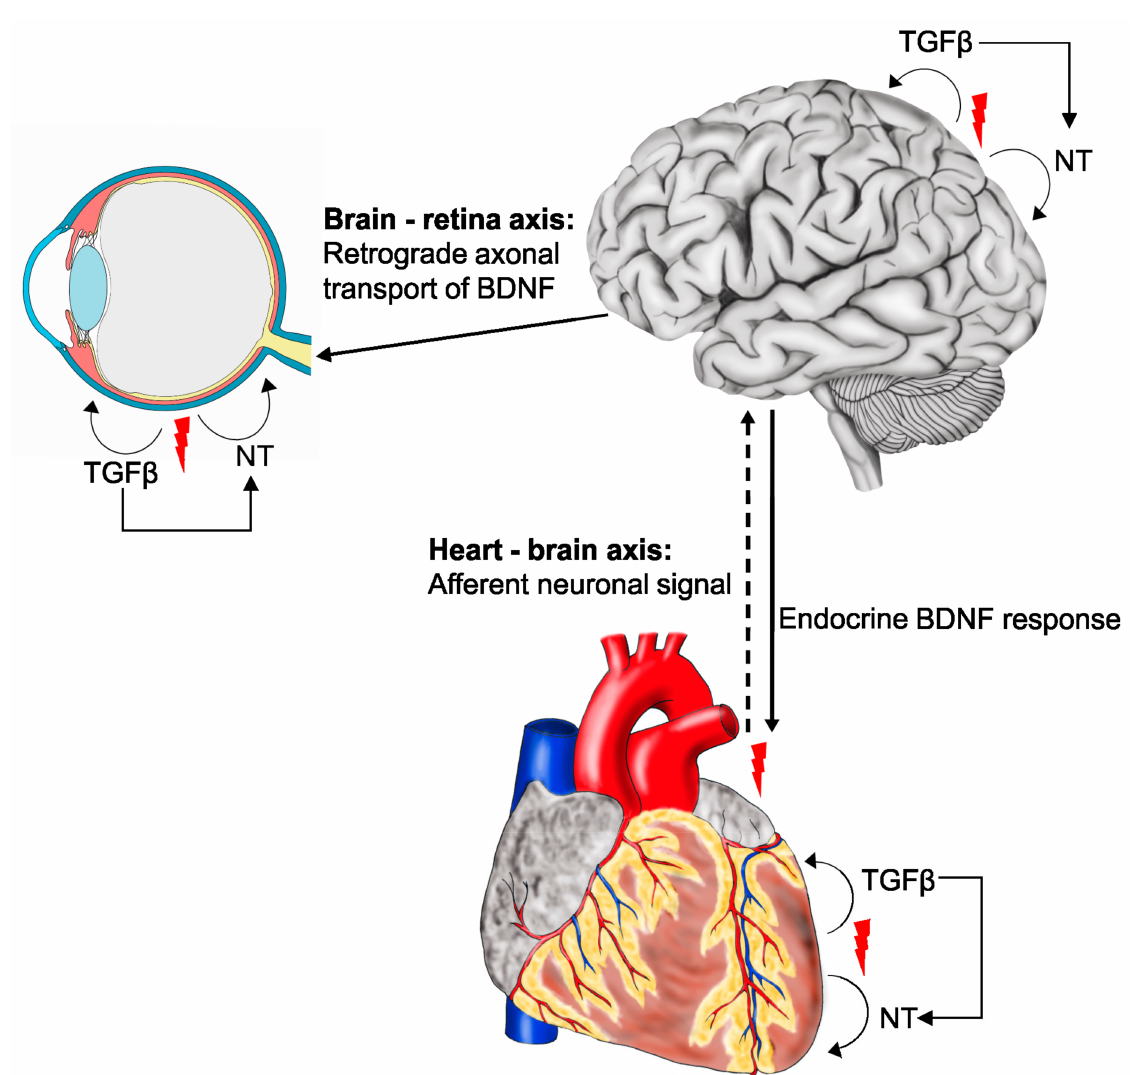
Figure 6. The heart-brain and brain-retina axis. Neurotrophins (NT) and TGF β are upregulated following ischemic insults (red lightning symbol) to the heart, retina, and brain. Following myocardial infarction, the heart-brain axis is activated by transmitting mechano- and chemo-sensitive information through cardiac afferent fibers (dotted arrow) to the brain, which responds by releasing BDNF to the bloodstream. Thus, BDNF promotes recovery from myocardial infarction by endocrine and paracrine actions. TGF β directly affects repair processes following ischemic insults. Moreover, it has the ability to increase the expression of NT. Additionally, retrograde transport of neurotrophins is essential for survival of retinal ganglion cells. This close relationship could be defined as a brain-retina axis. TGF β = transforming growth factor β , NT = neurotrophin, BDNF = brain-derived neurotrophic